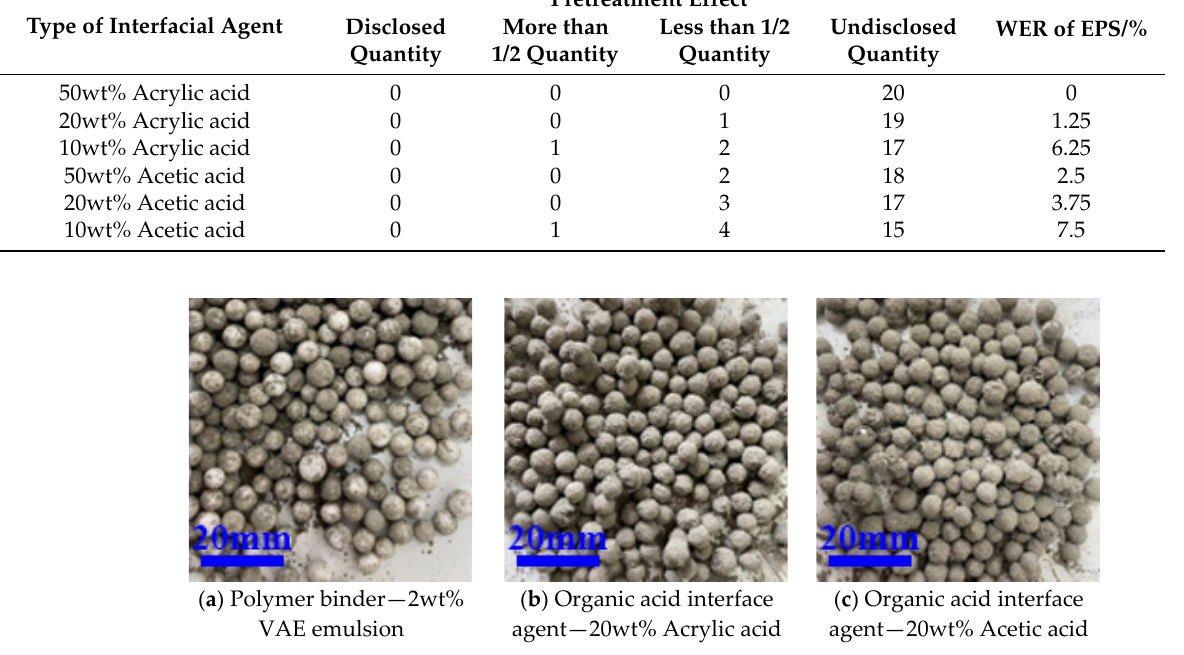
Table 5. Effect of organic acid on the WER of CSLA.